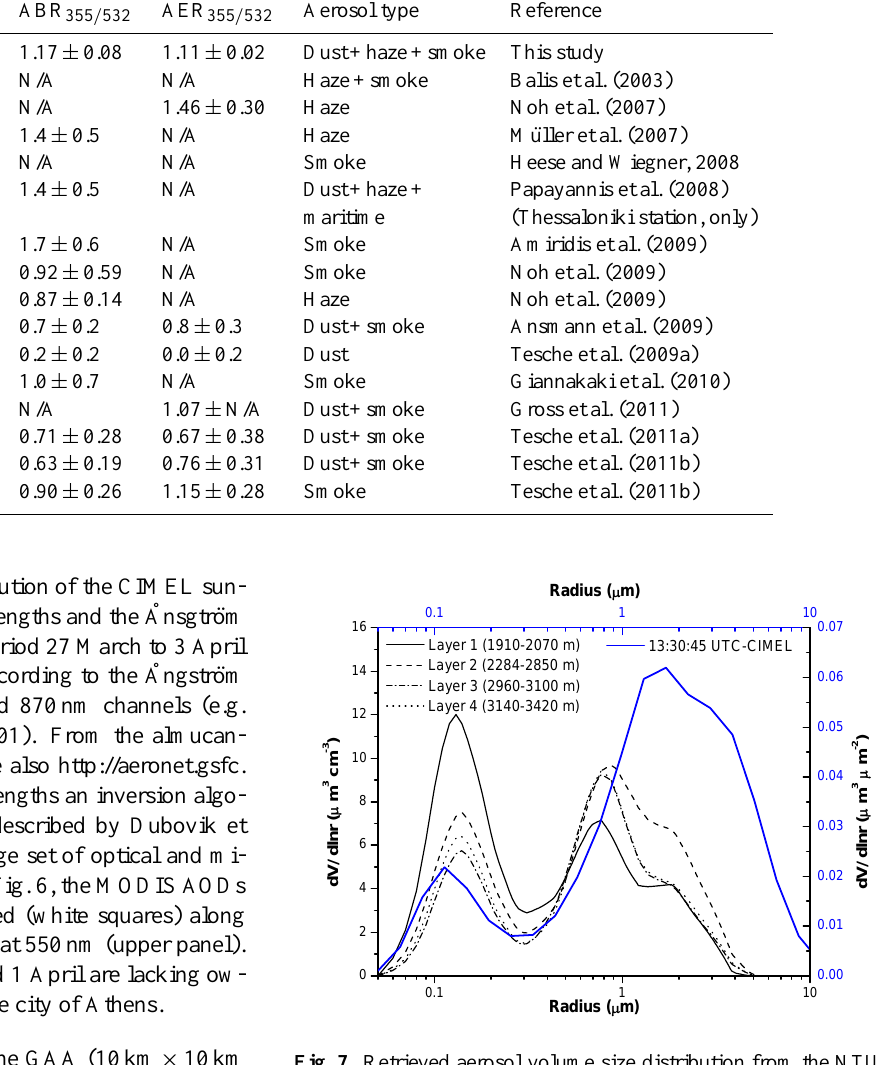
ground AODs are slightly lower than those reported for lo- cal haze conditions, and much lower for dust conditions (AOD > 0.4). The temporal evolution of the ˚Angstr¨om ex- ponent (440–870 nm) for the same time period is also shown in the lower panel, showing low values (from 0.4 to 1.0) for 2 and 3 April, in inverse correspondence with the high AOD for desert aerosols. One of the characteristics of the desert dust episodes in our area (Balis et al., 2004) is the high vari- ability shown by both parameters during each